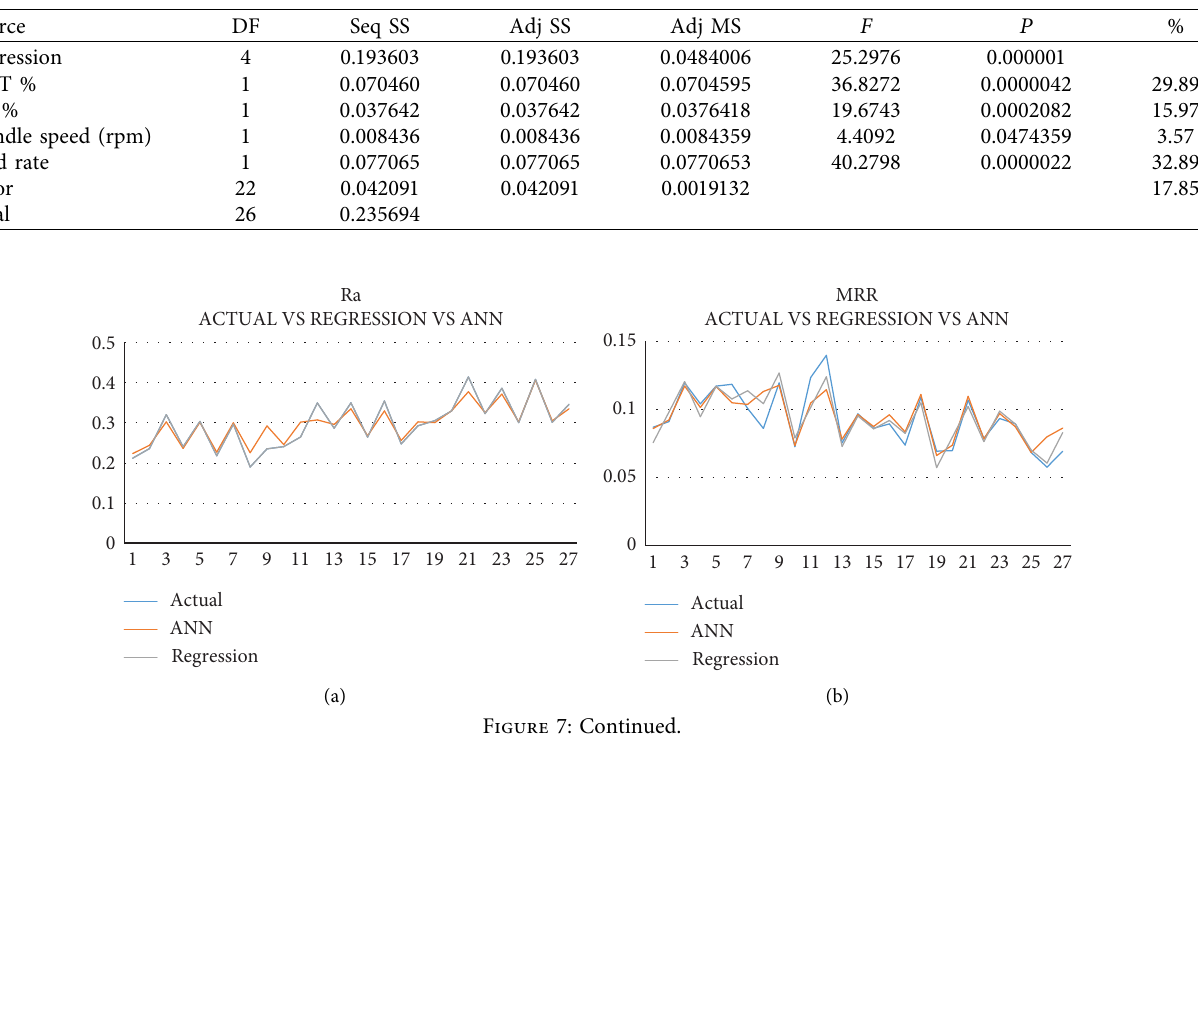
Figure 6: GRG. Table 6: Te ANOVA results of the